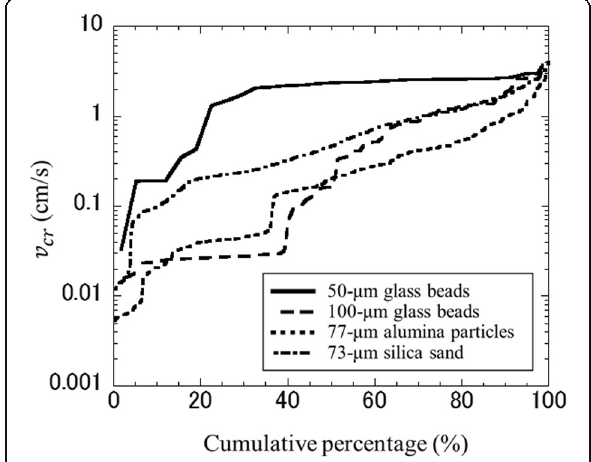
Fig. 10 Calculated critical collision velocity for equal-size agglomerates versus the cumulative percentage. This percentage is based on the number of detached particles/total number of detached particles ratio, as shown in Fig. 6a. Solid, dashed, dotted, and dashed and dotted lines show 50 μ m glass beads, 100 μ m glass beads, alumina particles, and silica sand,